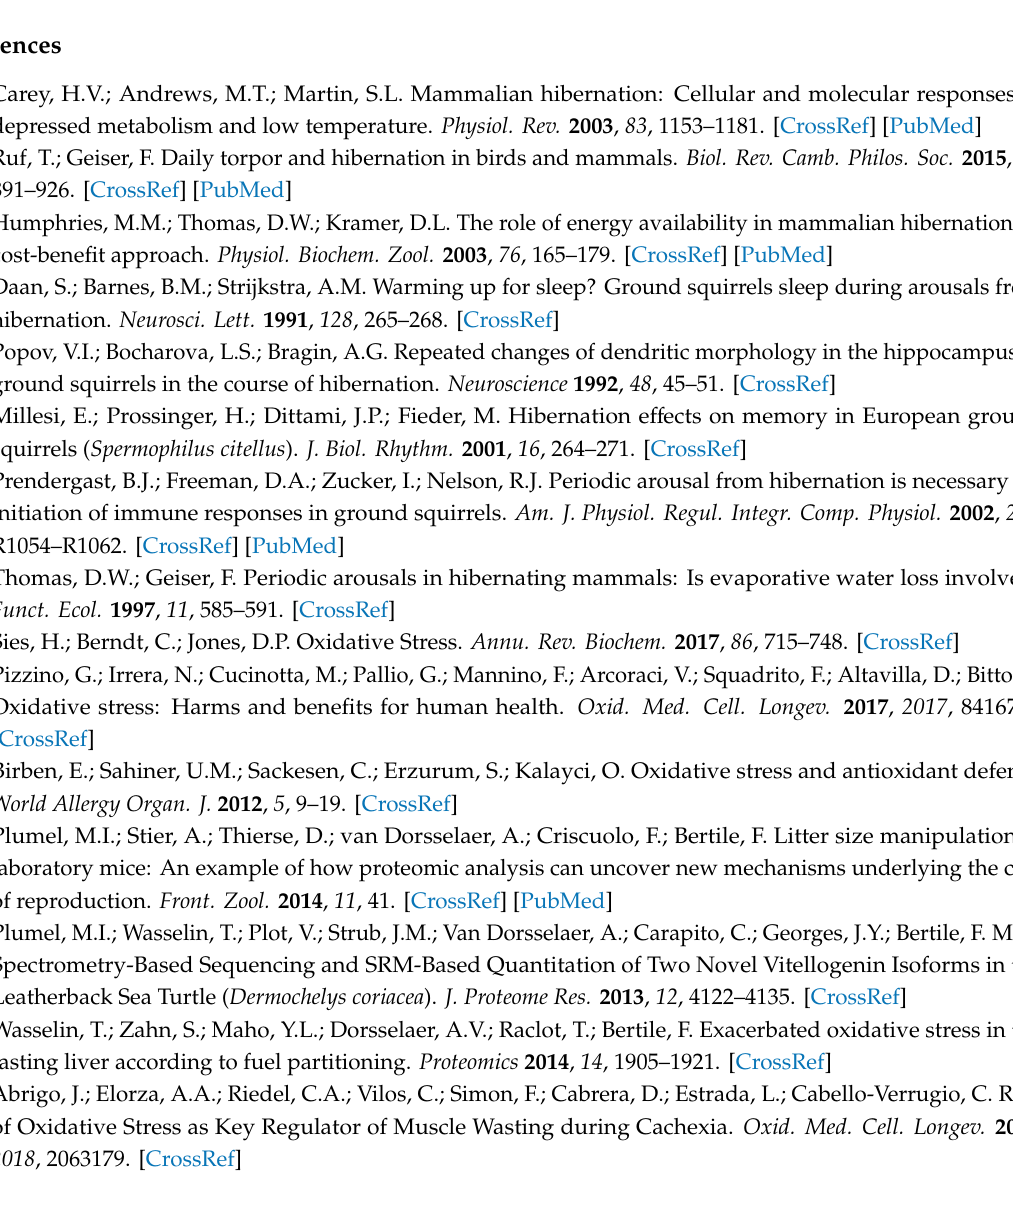
Figure S1: Representative blots of bear skeletal muscle